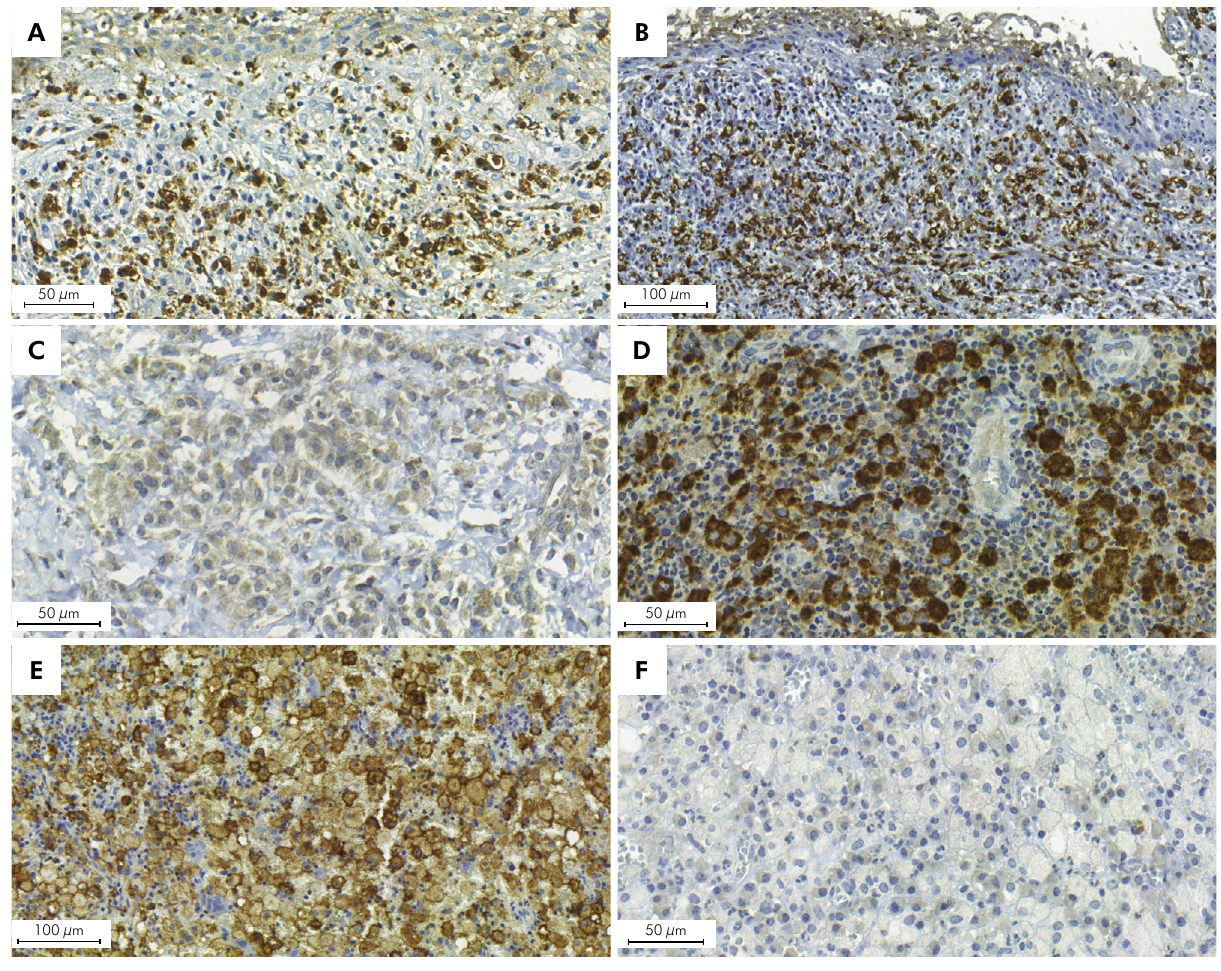
Figure 2. (A) CD68 immunostaining in lysosomal granules and macrophage surfaces in RCs (Scale bar 50 μ m); (B) CD163 immunostaining indicates M2 macrophages in RCs (Scale bar 100 μ m); (C) Score 3 RC capsule TNF- α immunostaining (Scale bar 50 μ m); (D) PG CD68 immunostaining and intense inflammatory infiltrate (Scale bar 50 μ m); (E) High percentage of CD163 membrane immunostaining in PG histiocytes (Scale bar 100 μ m); (F) Score 1 TNF- α PG immunostaining (Scale bar 50 μ m).